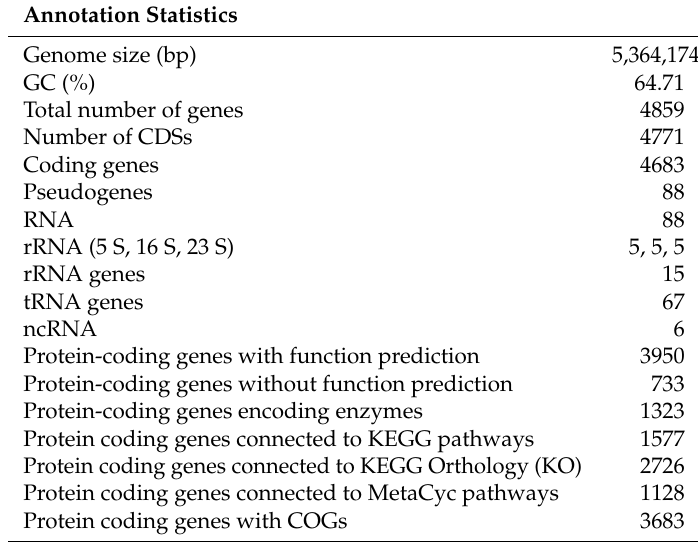
Table 1. Genomic features, gene prediction, and annotation summary of the CS51